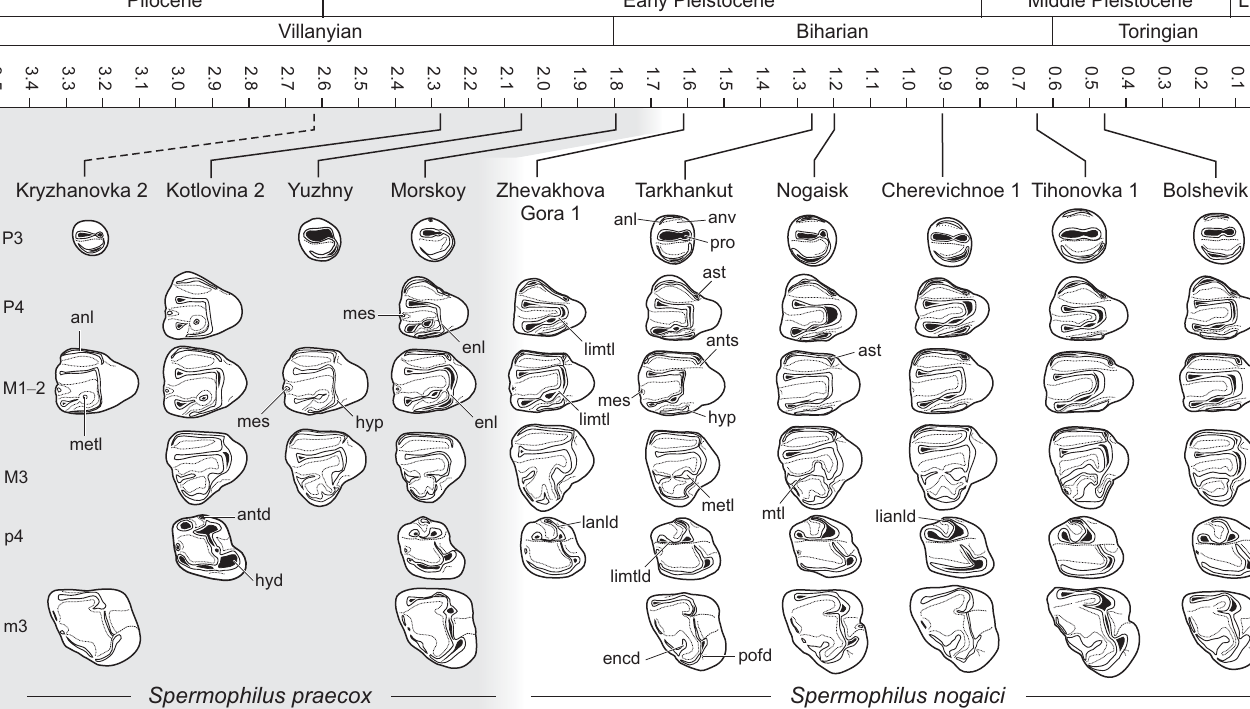
Fig. 8. Temporally-calibrated dental variation in P3, P4, M1–M2, M3, p4, and m3 of Spermophilus praecox sp. nov. and Spermophilus nogaici (Topachevsky, 1957). Abbreviations: anl, anteroloph; ants, antesinus; ast, anterostyle; antd, anteroconulid; anv, anterior valley; encd, entoconulid; enl, en- doloph; hyd, hypoconid; hyp, hypocone; lanld, labial anterolophid; LH, Late Pleistocene–Holocene; lianld, lingual anterolophid; limtl, lingual metaloph; limtld, lingual metalophid; mes, mesostyle; metl, metaconule; pofd, postflexid; pro,